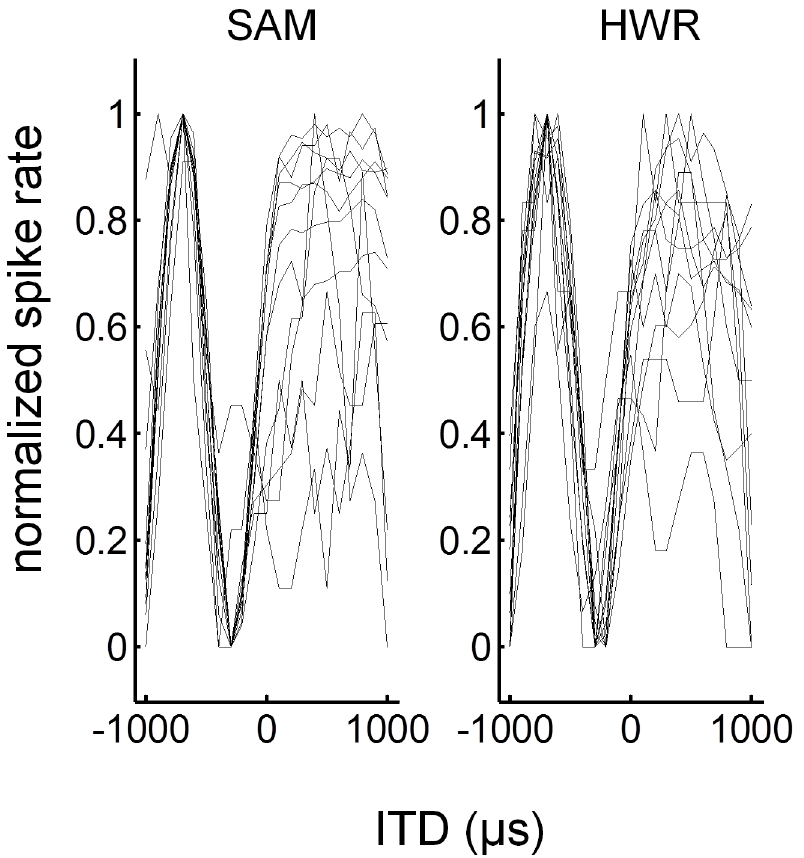
Figure 7. ITD functions in normal-hearing animals. Examples of normalized ITD functions in response to SAM and HWR tones. Each ITD response function was derived from evenly spaced recording locations along the same electrode penetration, positioned orthogonal to the cortical surface.